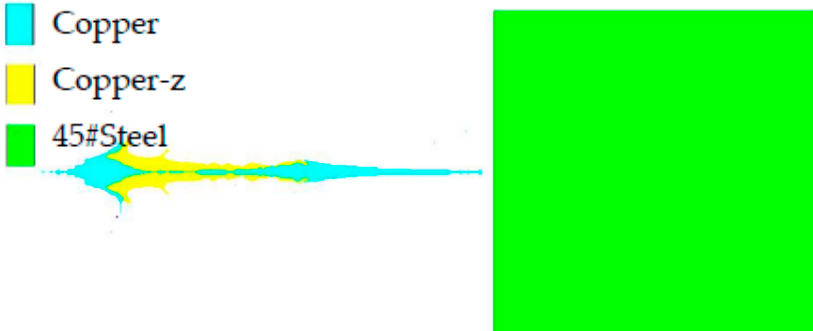
Figure 16. Penetration model of explosive charge jet.